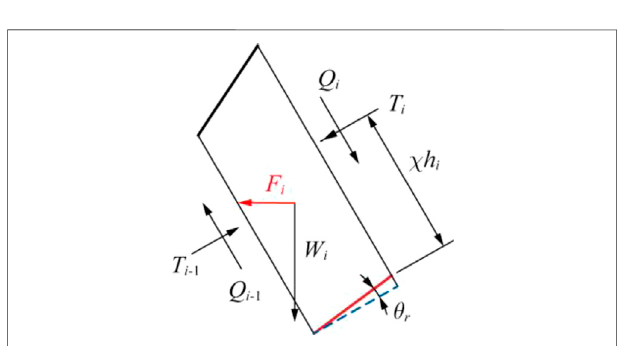
FIGURE6| Limitequilibriumanalysisofrockmasstopplingfailureabove stratum layer # i under horizontal pseudo-static load.